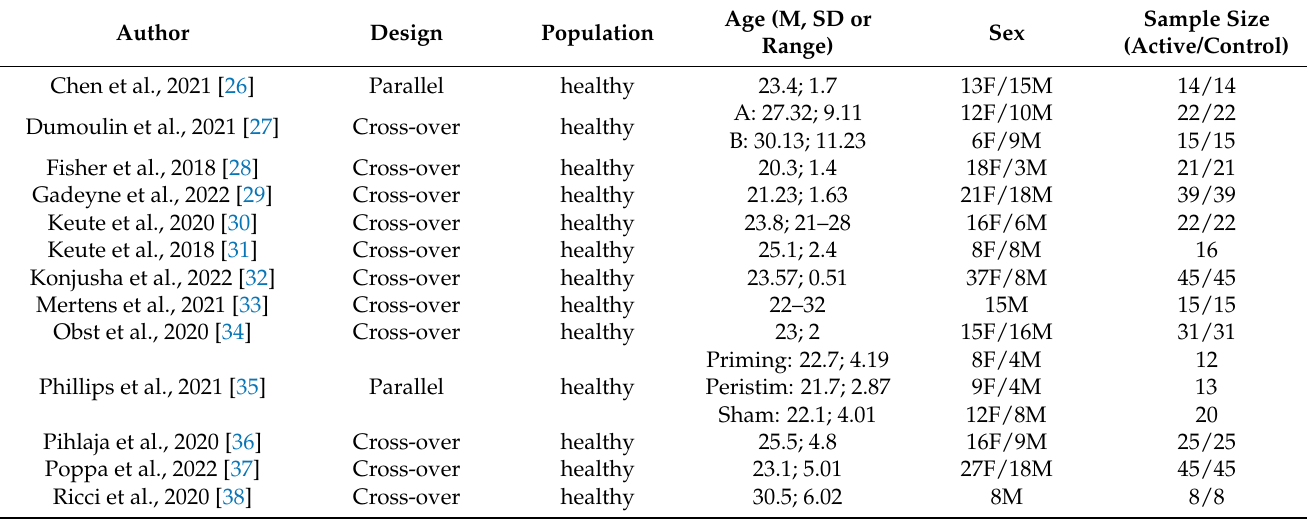
Table 1. Descriptive data of the included studies.